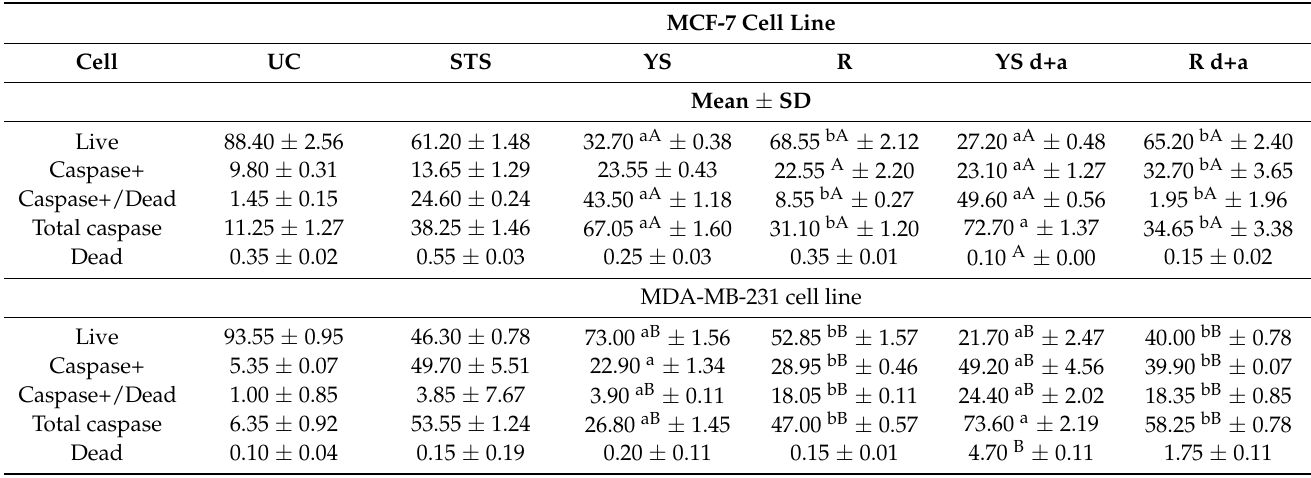
Table 6. Comparison of caspase activation capacity of the tested juices in cancer cells [%] using flow cytometry (Muse ® Cell